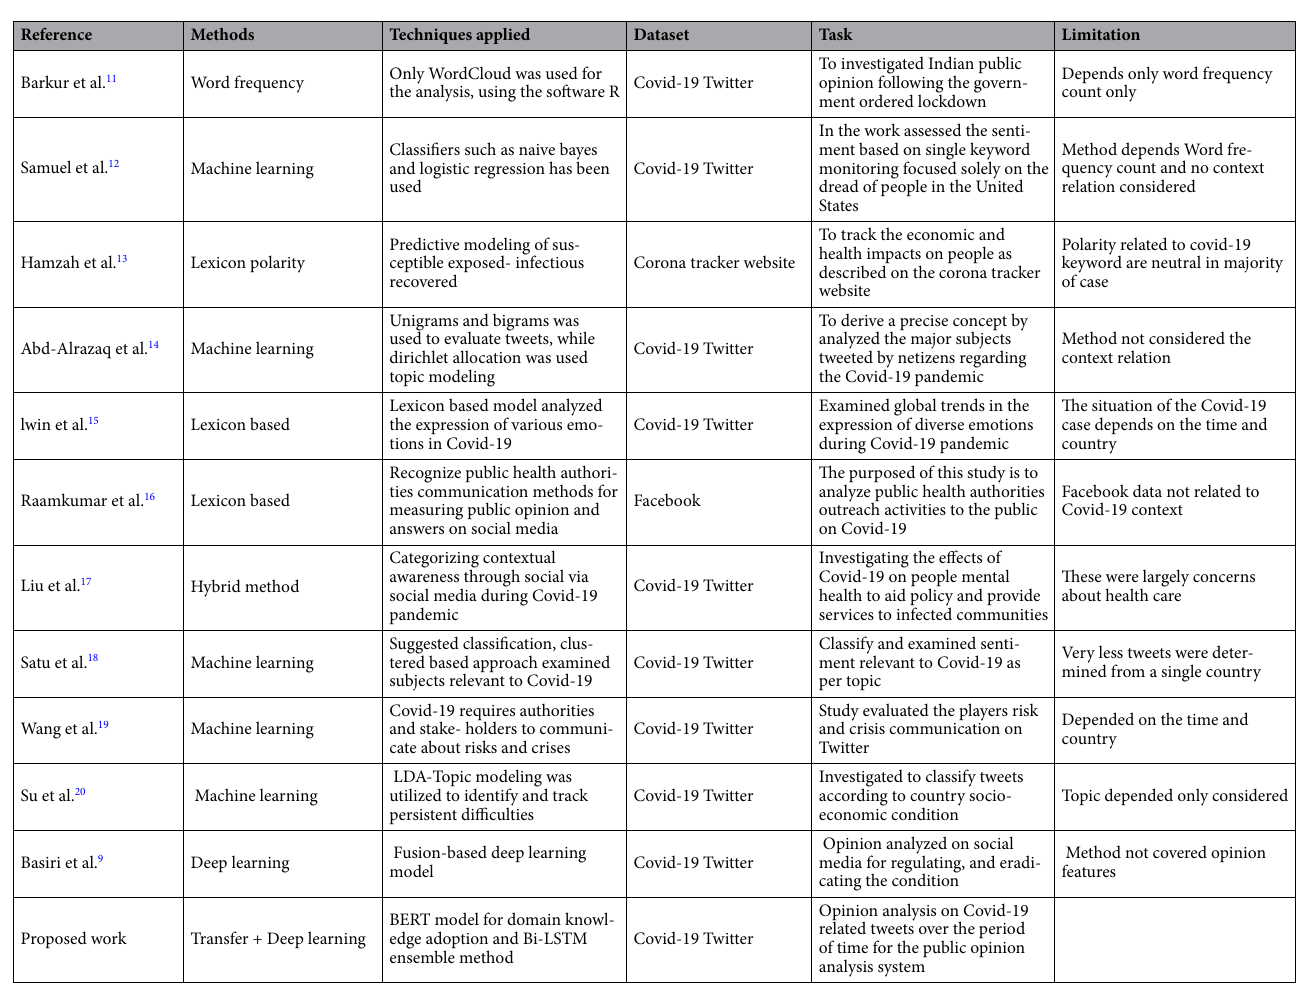
Table 1. Comparative analysis of different